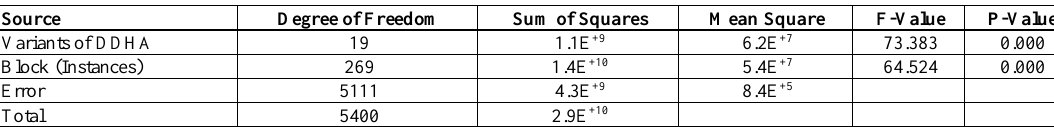
Table 5. The results of